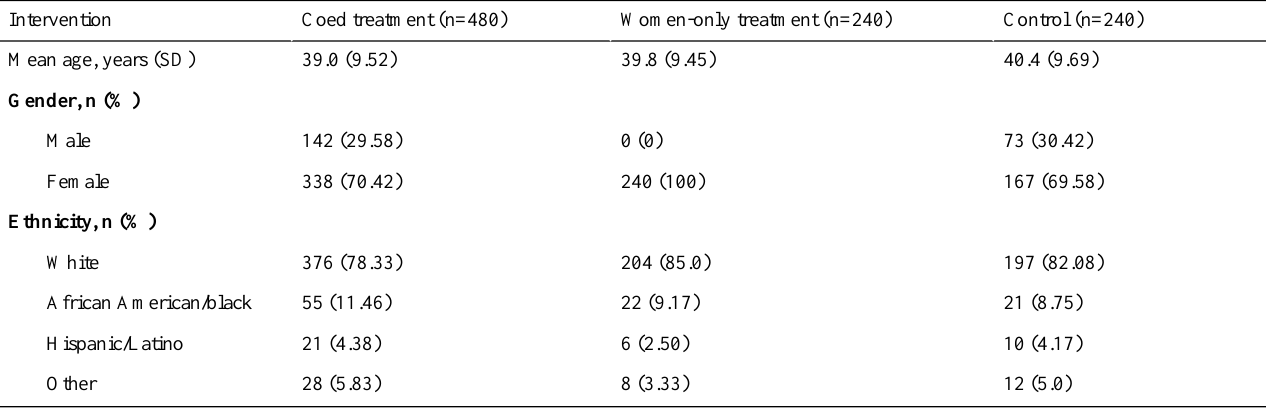
Table 2. Demographics of participants in the randomized controlled trial by